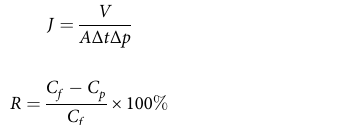
Table 6) and suf fi cient mechanical